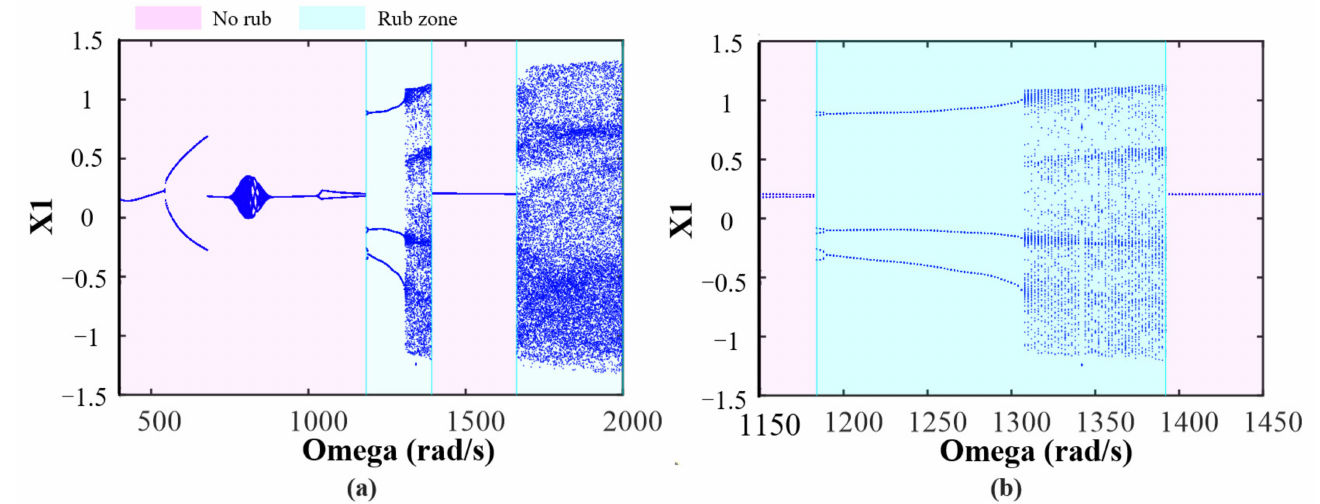
Table 3. Rotating speed range for rubbing and chaotic motion at different rubbing positions. Rubbing Position Disc 1 Disc 2 Disc 3